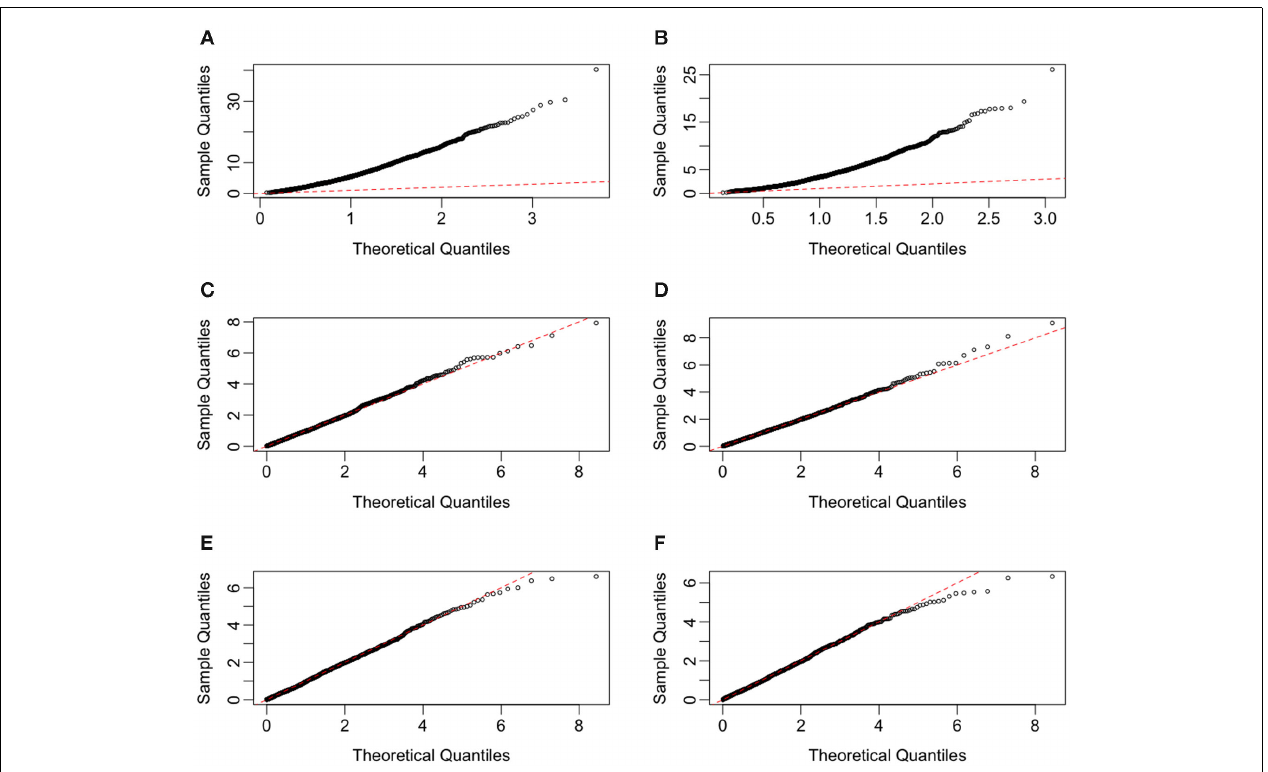
and AUC para , respectively.The red dotted line in each plot represents an idealized case where theoretical test statistic quantiles match simulated test statistic